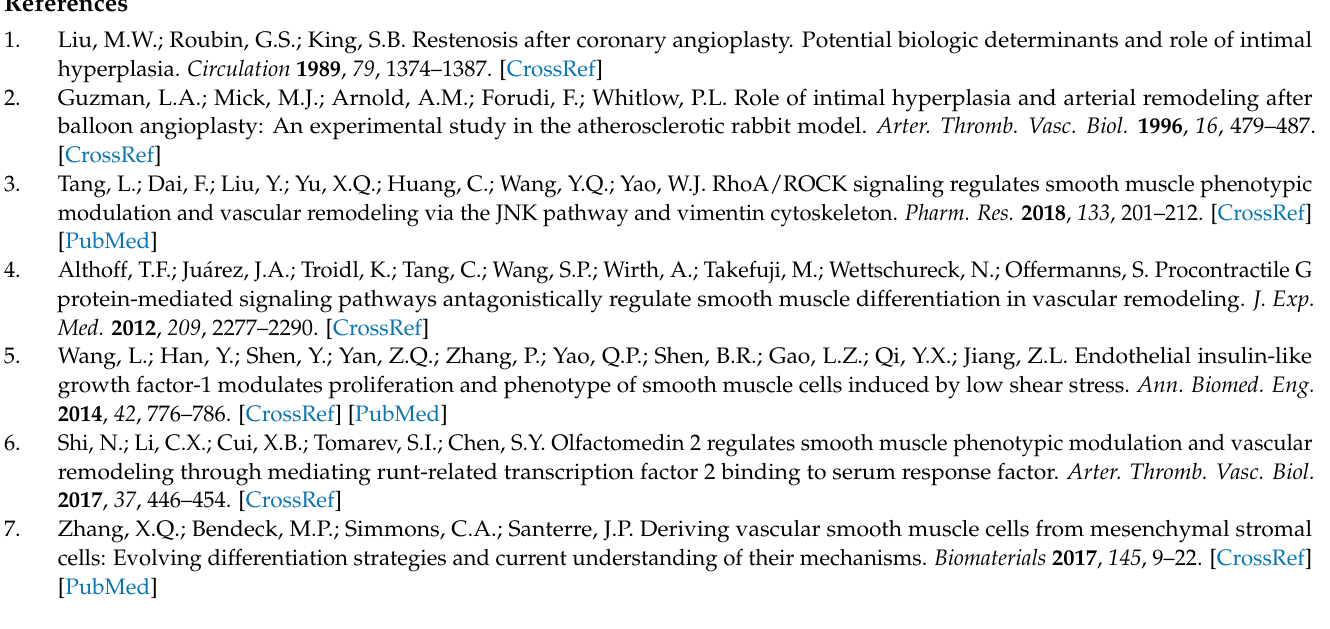
PDGF-BB. Figure S3: Rac1 inhibition does not affect PDGF-BB-induced phenotypic transition in HA-VSMCs. Figure S4: The confirmation of RhoGDI1 and Cdc42 knockdown in rats by western